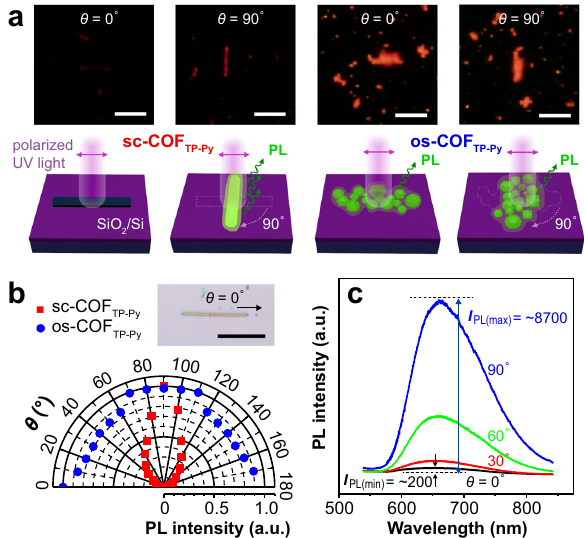
Fig. 5 Polarized photoluminescence. a Polarized fl uorescence microscopy images and schematic illustration of sc-COF TP-Py and os-COF TP-Py at θ = 0° and 90°. b Angle-dependent PL intensity at different θ . The inset is an optical microscopy image of a sc-COF TP-Py crystal. c PL spectra of the crystal when θ is 0°, 30°, 60°, 90°. The DR (de fi ned as I PL(max) / I PL(min) ) is calculated to be 43.5. The scale bars are 10 μ m in ( a ), 20 μ m in ( b